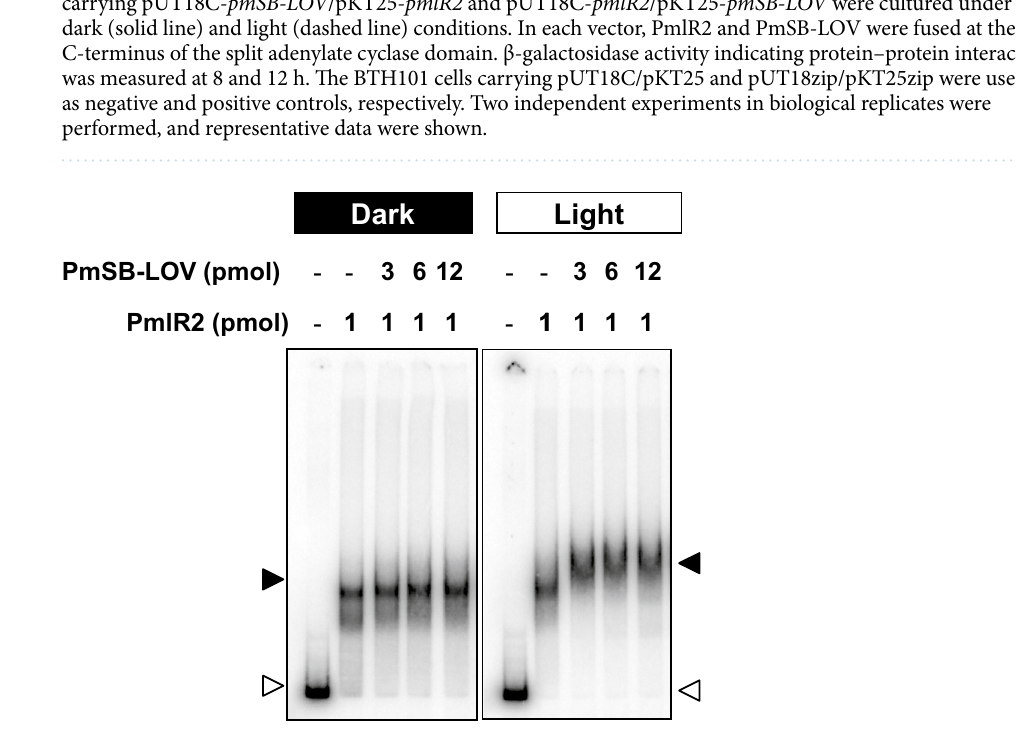
Figure 5. Gel-shift assay of PmlR2 and PmSB-LOV with P 6650 . The indicated amounts of proteins were incubated under dark (left panel) or white light (right panel) conditions before the addition of a total of 0.5–5.0 ng of 32 P-labeled probe. Continuous irradiation of the polyacrylamide gel during electrophoresis was required for the super shift composed of PmlR2, PmSB-LOV, and the probe. Open and closed triangle denote the probe and protein-DNA complex, respectively. Three independent experiments in technical replicates were performed, and representative data were shown. The original and unprocessed versions of the full-length gels were included in Fig.